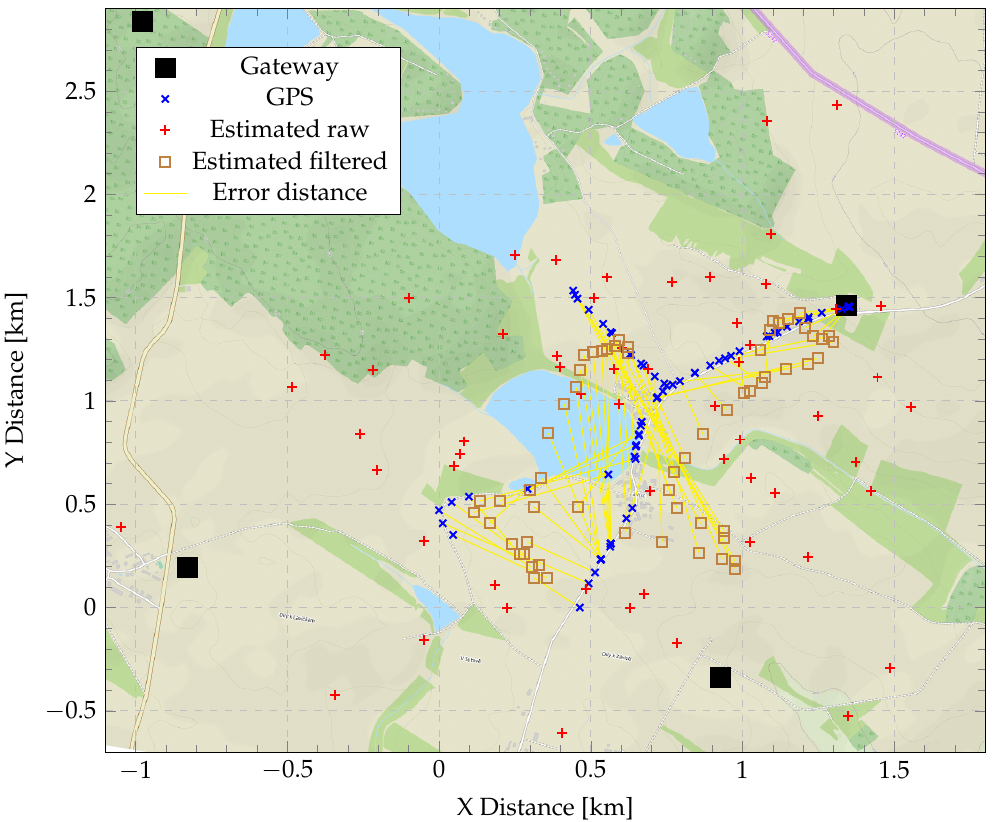
Figure 16. Position estimation using Chan’s and Foy’s algorithms after filtration compared to the real GPS